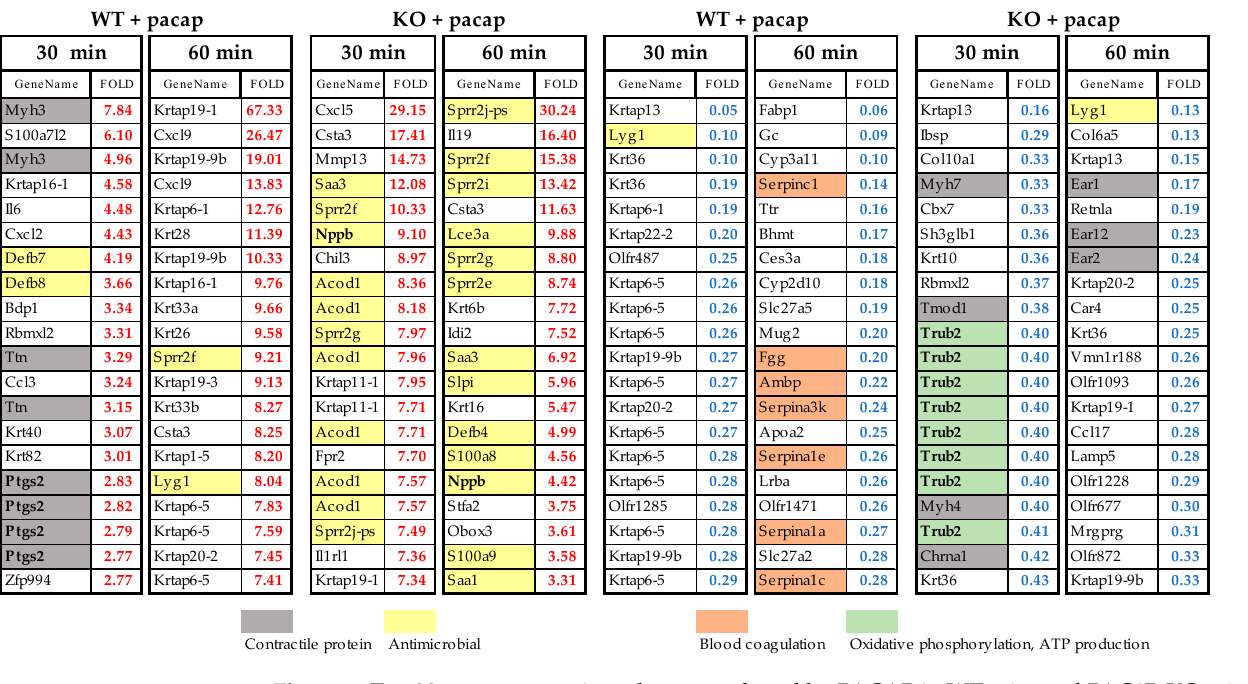
Figure 5 . Top 20 genes expressions that were altered by PACAP in WT mice and PAC1R KO mice. Genes involved in contractile protein ‐ related genes (gray), antimicrobial activity (yellow), blood coagulation ‐ related genes (orange), and oxidative phosphorylation ‐ and ATP production ‐ related genes (green). The gene expression data are publicly available under the GEO series accession number GSE223124 (https://www.ncbi.nlm.nih.gov/geo/query/acc.cgi?acc=GSE223124; accessed on 19 February 2023).